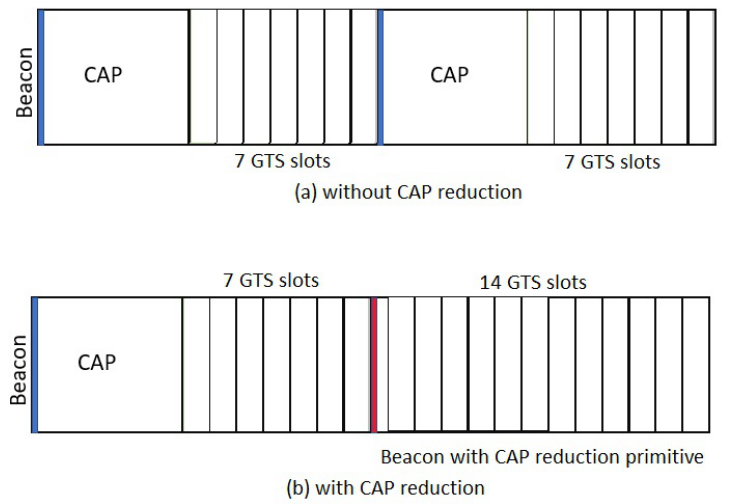
Figure 12. Contention Access Period (CAP) reduction architecture.( a ) without CAP reduction, ( b ) with CAP